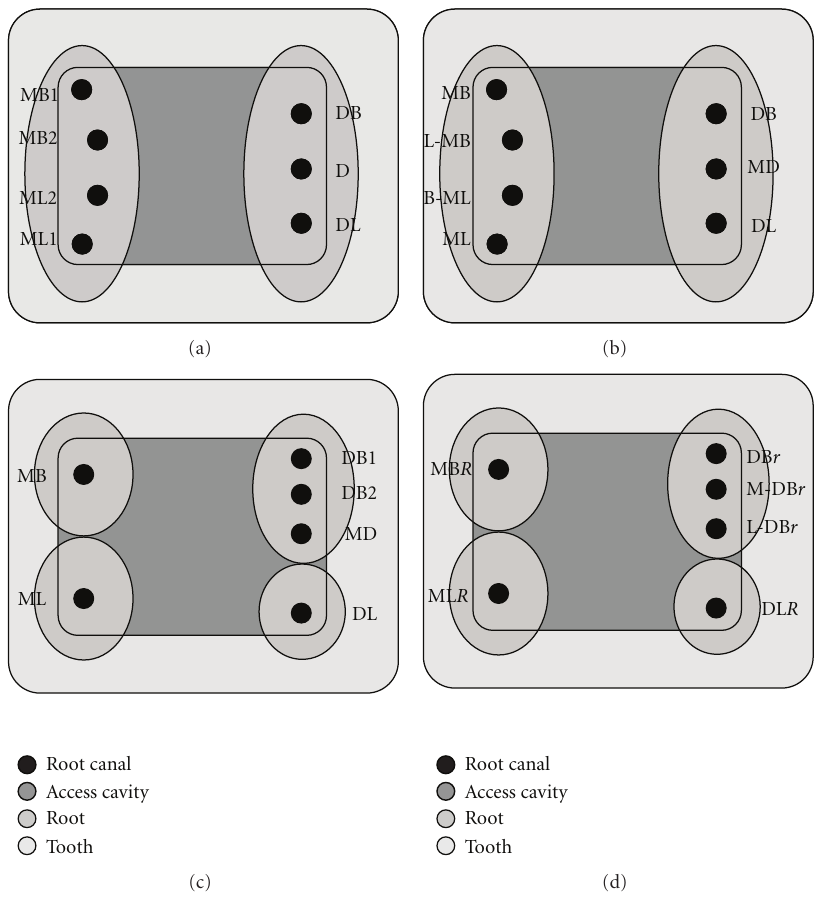
Figure 4: (a) Diagrammatic illustration of the access cavity of the mandibular first molar showing the locations of the seven canals contained within the principle roots and named using the traditional nomenclature. MB—mesiobuccal, ML—mesiolingual, DB—distobuccal, DL— distolingual, D—distal. (b) Naming of the canals in (a), as per the proposed anatomically based nomenclature, linguo-mesiobuccal (L-MB), bucco-mesiolingual (B-ML), MD—middle distal. (c) Diagrammatic illustration of the access cavity of the mandibular first molar showing the locations of the six canals contained within four roots and named using the traditional nomenclature. (d) Naming of canals, shown in (c), in accordance with the recommended nomenclature which clearly conveys the information of the root and canal morphology of the tooth. “R” is added as a su ffi x to the name of the canal to signify additional root(s) with a single canal (MB R —mesiobuccal, ML R — mesiolingual, DL R —distolingual); “r” is added as a su ffi x to the names of all the canals in the additional root containing multiple